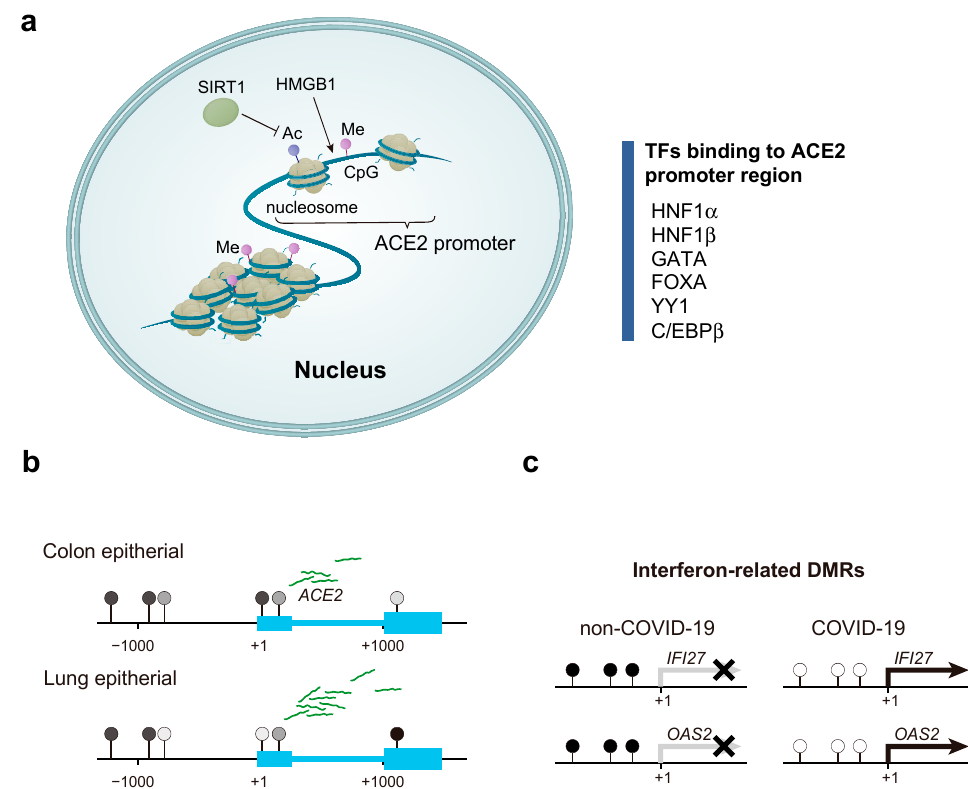
Figure 2. The effect of chromatin organization and DNA methylation on angiotensin I converting enzyme 2 (ACE2) gene expression in patients with coronavirus disease 2019 (COVID-19). ( a ) ACE2 gene expression is subject to a variety of epigenetic controls. Here, we focus on transcription factors that bind to the ACE2 promoter region, factors that convert chromatin structure (HMGB1), histone deacetylases (SIRT1), and DNA methylation. ( b ) In cells with low ACE2 expression, such as intestinal epithelial cells and vascular endothelial cells, CpG sites around the promoter are hypermethylated. On the contrary, in lung epithelial cells with high ACE2 expression, the CpG sites surrounding the promoter are hypomethylated, suggesting that DNA methylation regulates ACE2 gene expression. ( c ) Differentially methylated regions (DMRs), located around the promoters of interferon-related genes, are hypomethylated in patients with COVID-19 and are hypermethylated in patients without COVID-19. Balnis et al. performed a quantitative real-time polymerase chain reaction to estimate the expression of IFI27 and OAS2 and found that their expression was high in patients with COVID-19 and low in patients without COVID-19. This suggests that the interferon-related genes DMRs are hypomethylated in patients with COVID-19, resulting in the activation of these genes and